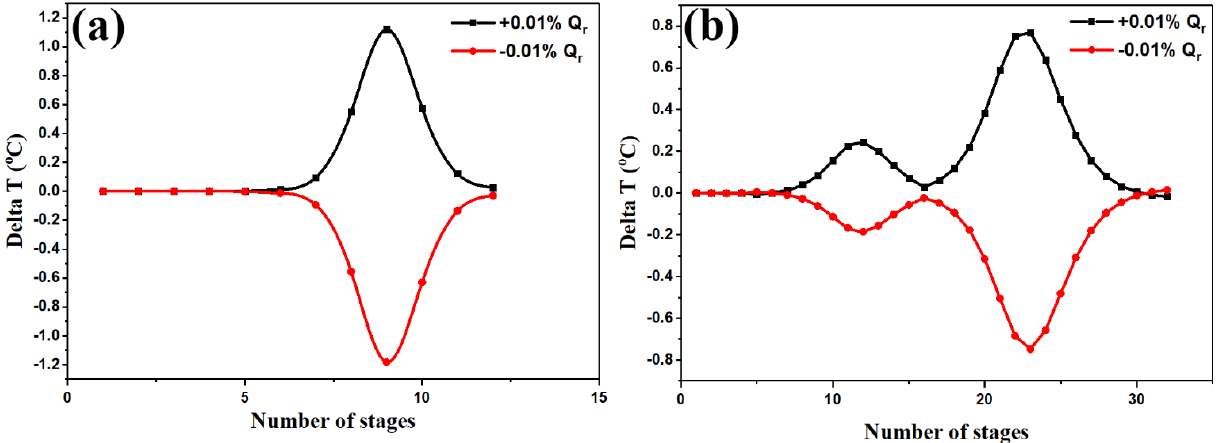
Figure 5. Open sensitivity analysis for determining the sensitive tray temperature: ( a ) a single tray; ( b ) dual trays.